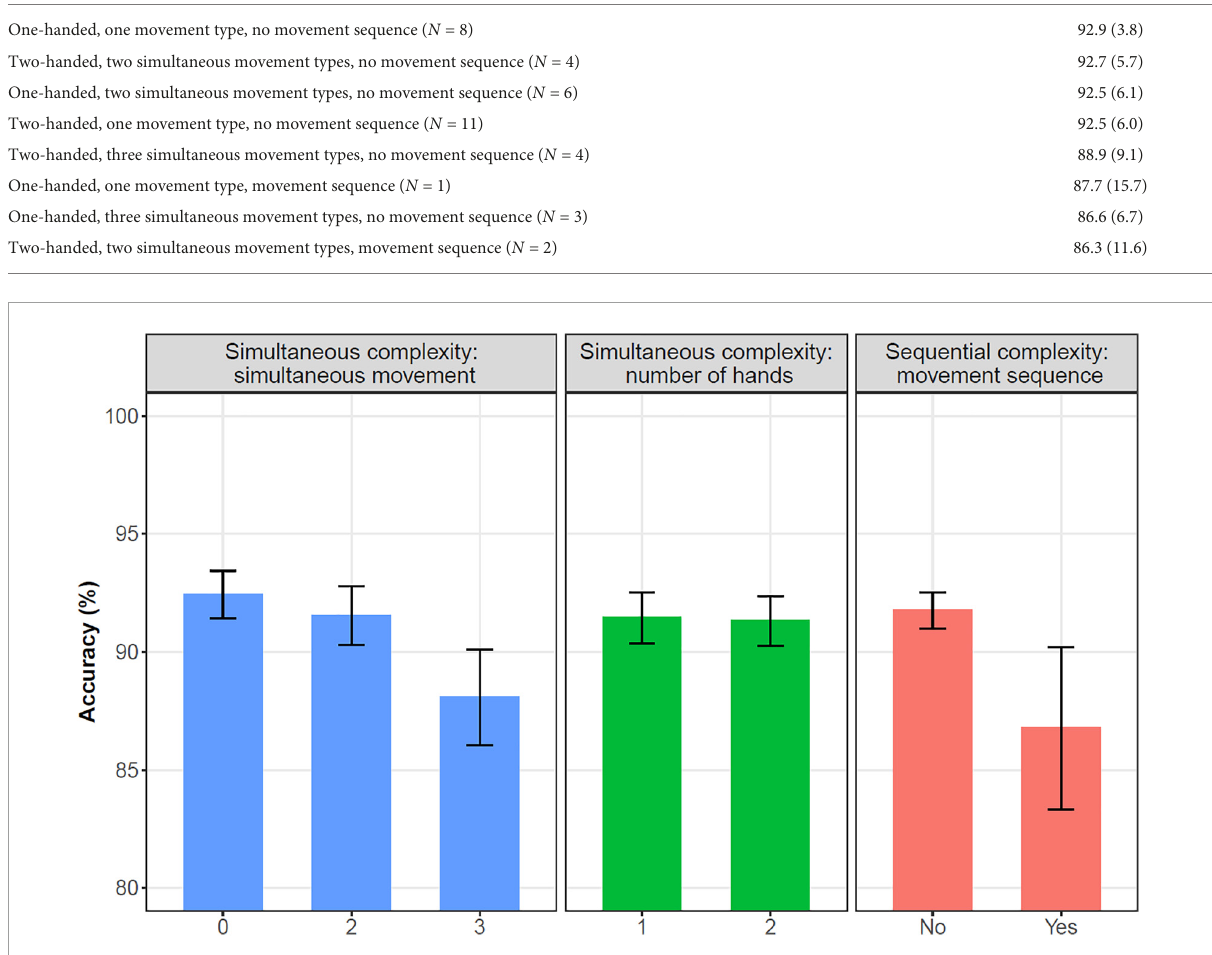
parameters (location: intercept = 0.770, slope = 0.024, p < 0.01; orientation: intercept = 0.817, slope = 0.018, p <